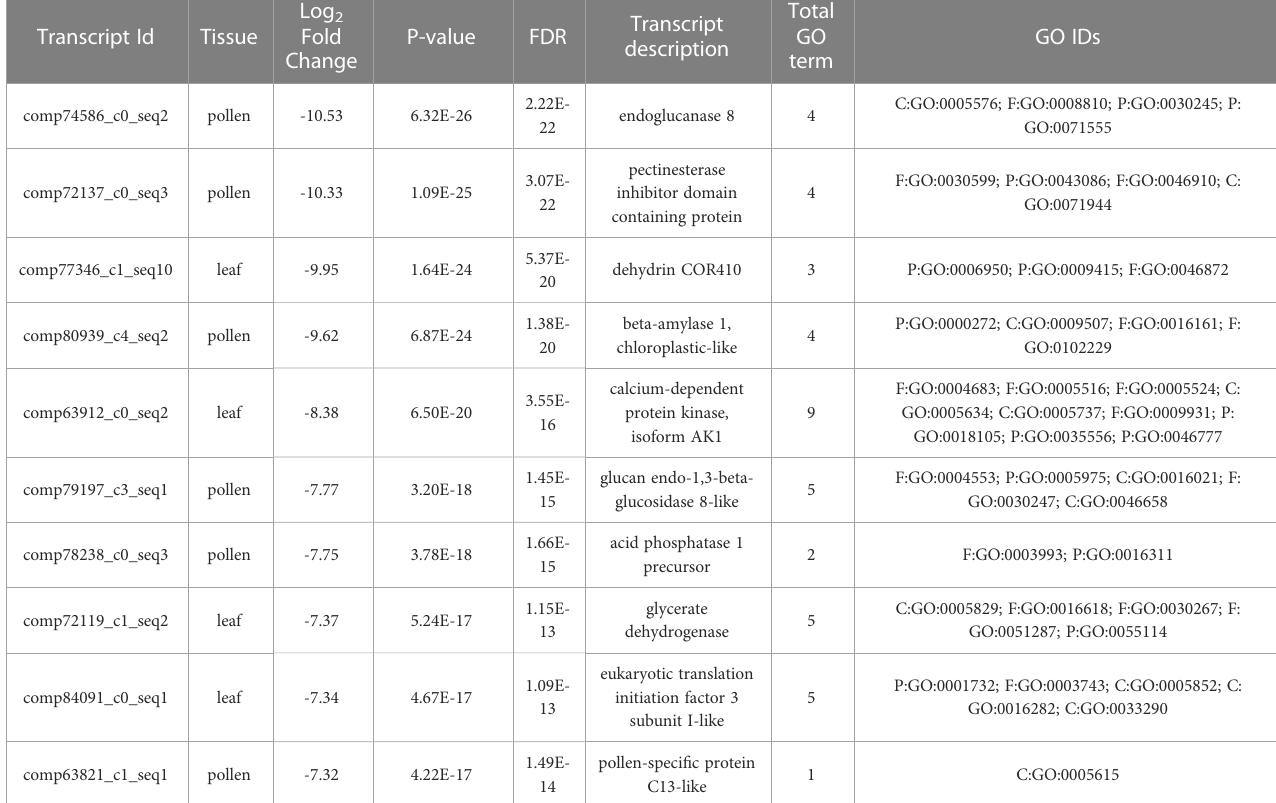
TABLE 3 Top 10 down-regulated DEGs in leaf, pollen, and ovule in comparisons of LM 11 and CML 25 inbreds under heat stress